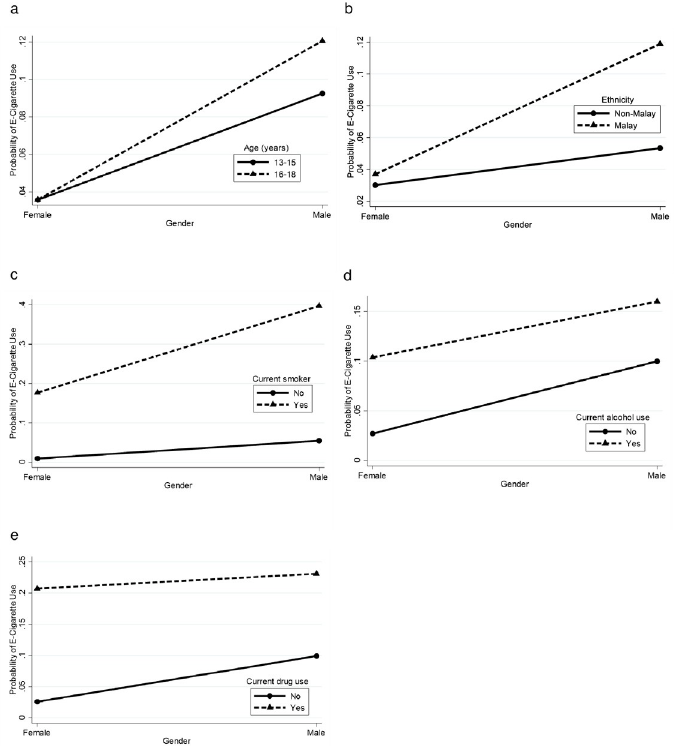
Fig 2. Probability of current e-cigarette use. (a) Gender-age: male (13–15 = 9.3%, 16–18 = 12.1%), female (13– 15 = 3.6%, 16–18 = 3.6%). (b) Gender-ethnicity: male (non-Malay = 5.3%, Malay = 11.9%), female (non-Malay = 3.0%, Malay = 3.7%). (c) Gender-current smoker: male (no = 5.5%, yes = 39.7%), female (no = 0.9%, yes = 17.7%). (d) Gender-current alcohol use: male (no = 10.0%, yes = 16.0%), female (no = 2.7%, yes = 10.4%). (e) Gender-current drug use: male (no = 9.9%, yes = 23.1%), female (no = 2.6%, yes = 20.7%).